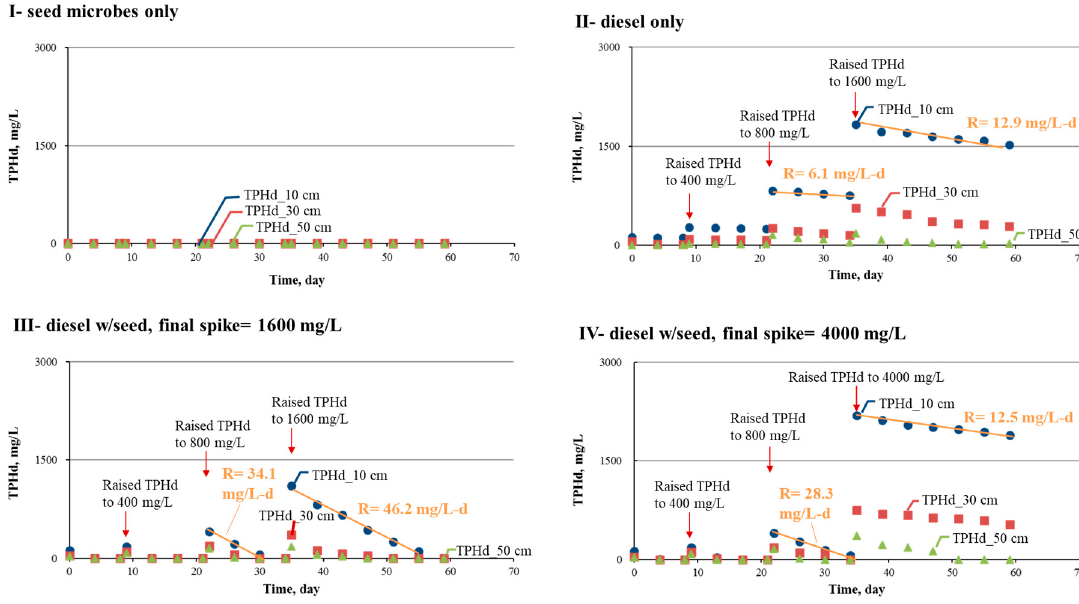
Figure 2. Acclimation of the seed microbes over 60 days with stepwise TPHd spiking strategies. R is the average daily TPHd removal rate in mg/L per day.